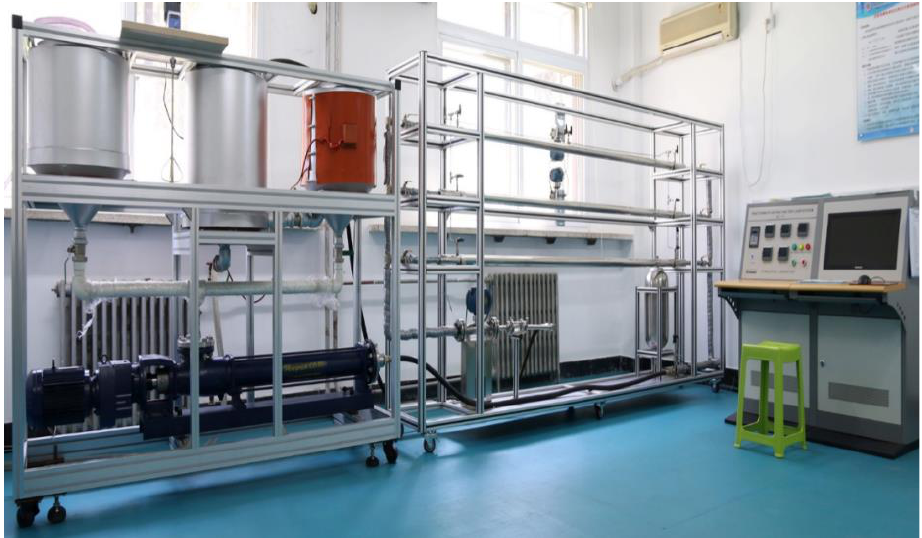
Figure 1. Loop flow drag test system.